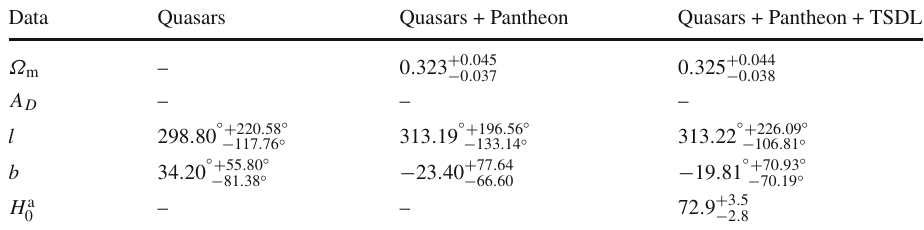
eters. The horizontal and vertical solid black lines denote the maximum of 1-dimensional marginalized posteriors. In